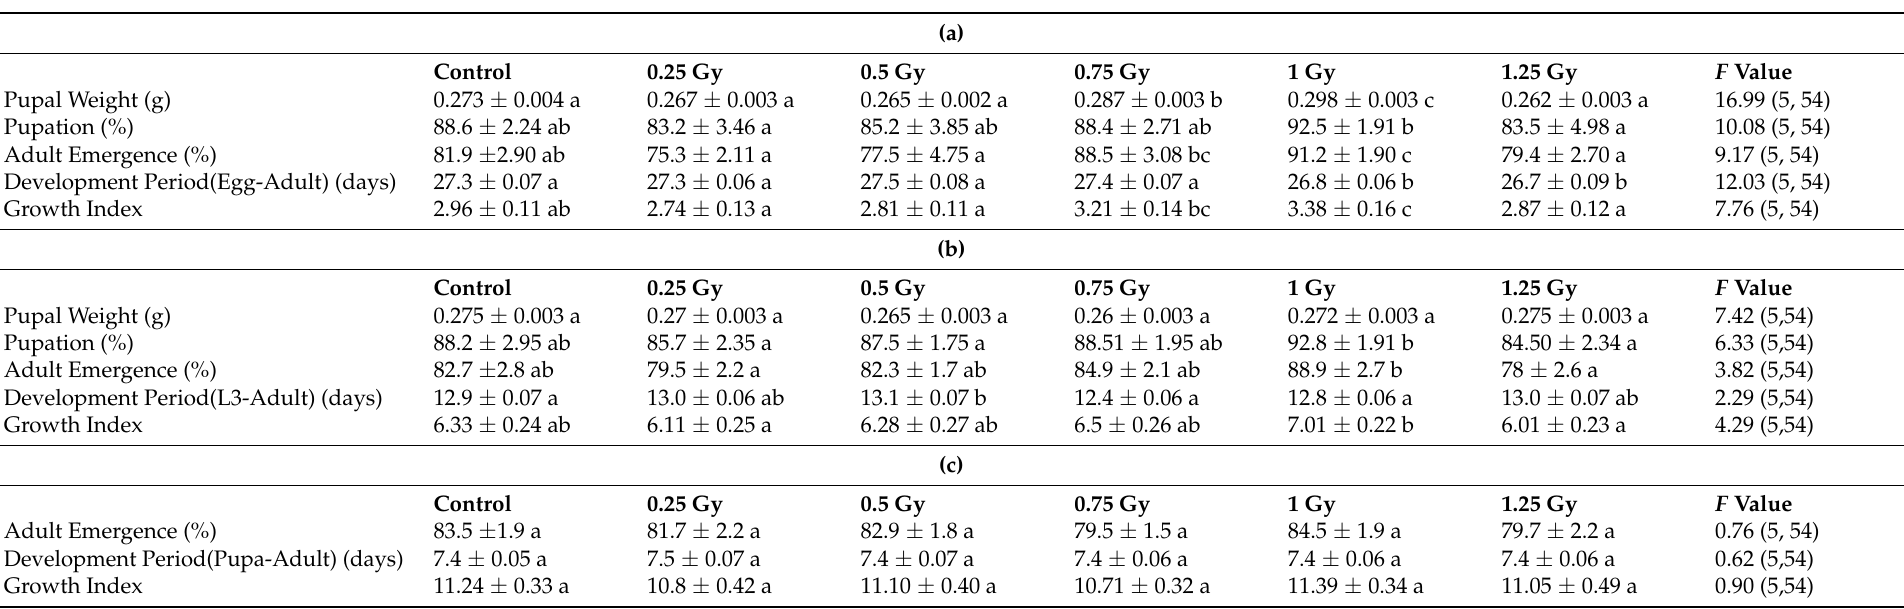
Table 2. ( a ): Effect of low-dose ionizing radiation (0.25–1.25 Gy) on growth features of Spodoptera litura (Fabr.) treated in egg stage. ( b ): Effect of low-dose